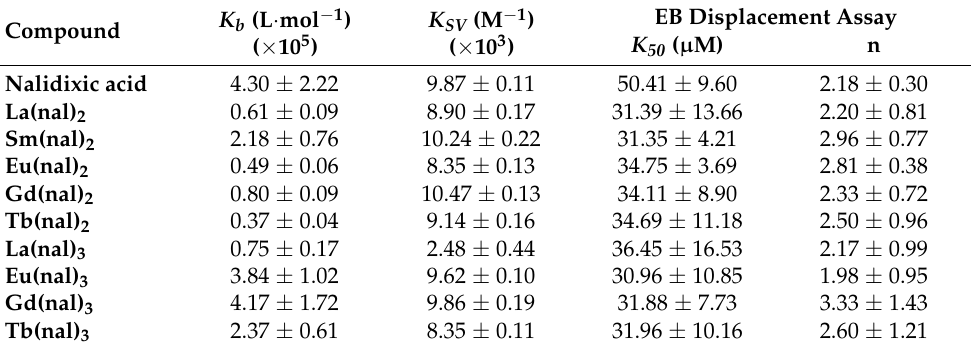
Table 2. Calculated values for the binding constants ( K b ), the Stern–Volmer quenching constants ( K SV ) and half maximum binding constants ( K 50 ) that characterize the interactions of the tested compounds with